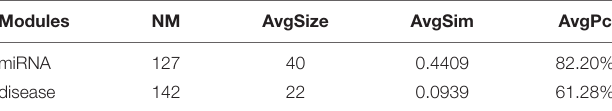
TABLE 7 | miRNA modules and disease modules detected by MDN-NMTF2 on HMDD2.0-Yan Dataset.